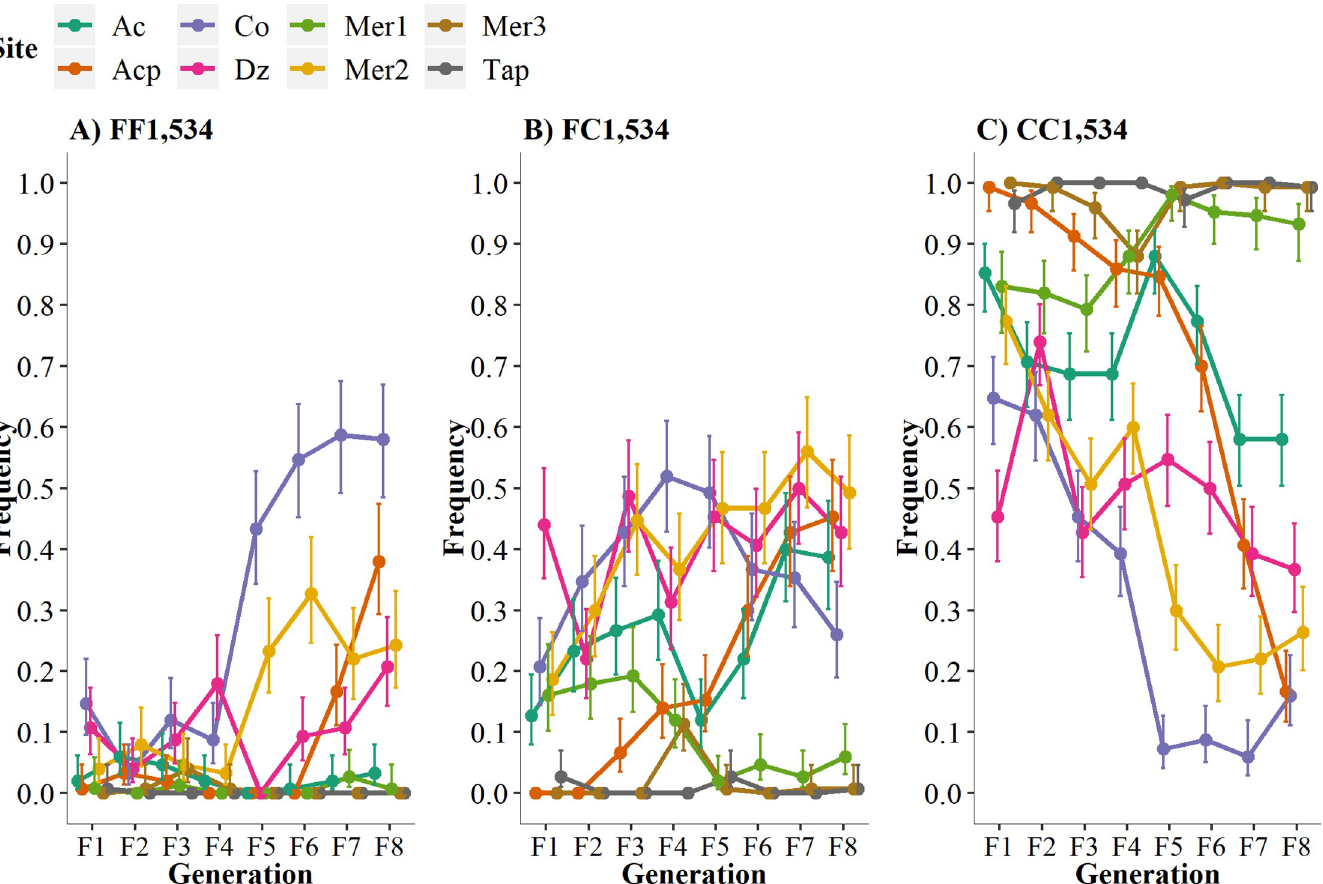
Fig 5. Frequencies of genotypes at locus F1,534C over eight generations in the absence of insecticides. Susceptible-homozygote = FF 1,534 , heterozygote = FC 1,534 , and resistant-homozygote = CC 1,534 .